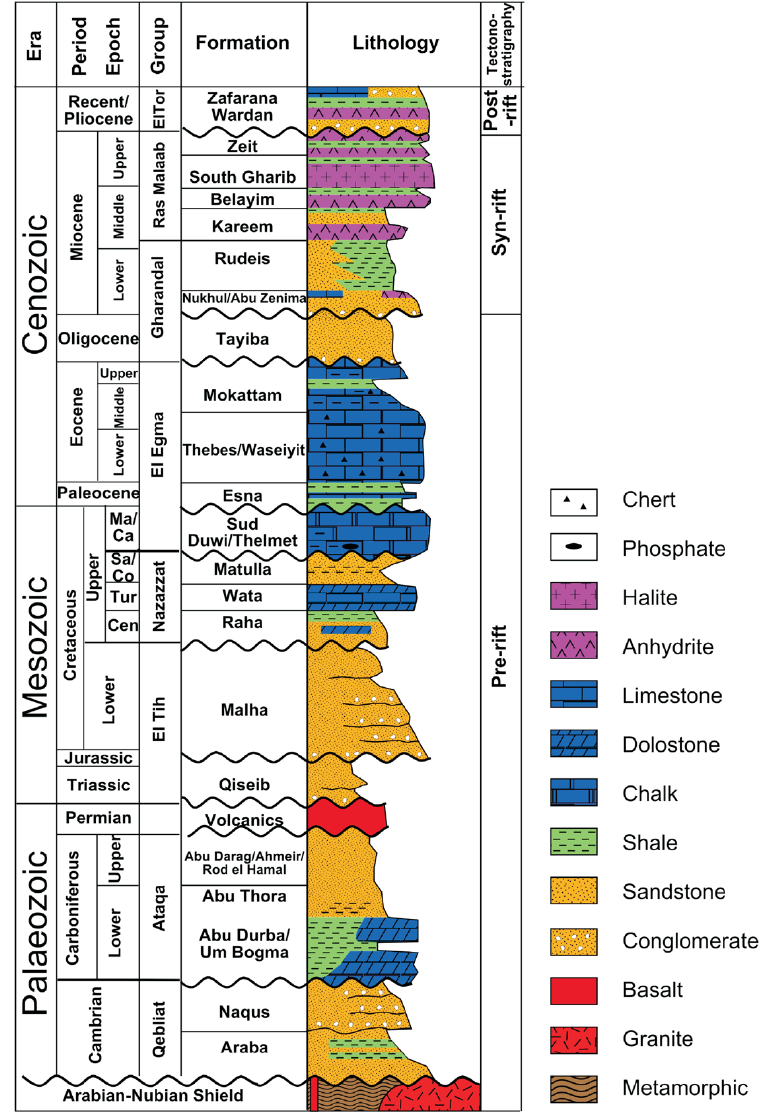
Figure 3. General lithostratigraphy of the Gulf of Suez region (modified after [50,51]).